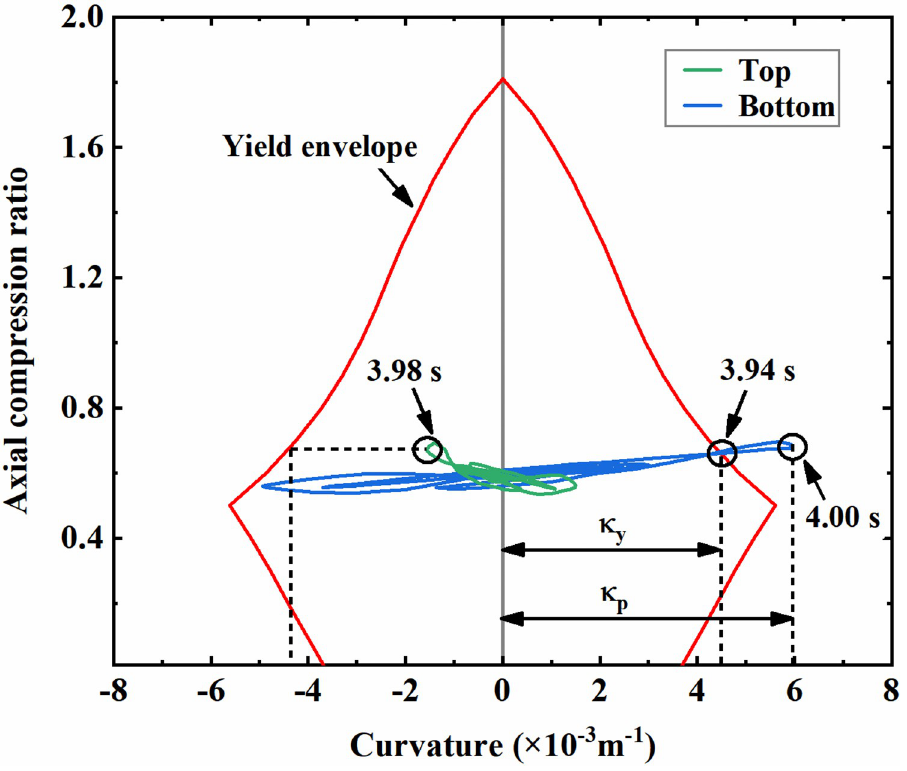
Fig 13. Yield curvature envelope of the column